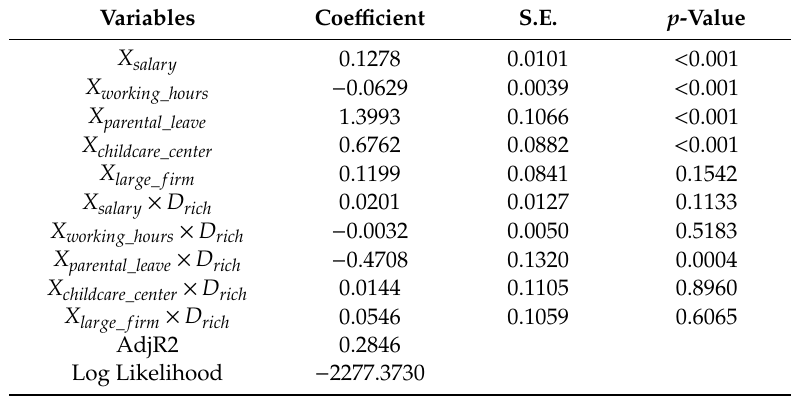
Table 11. Estimation results of the indirect utility function, by income level.